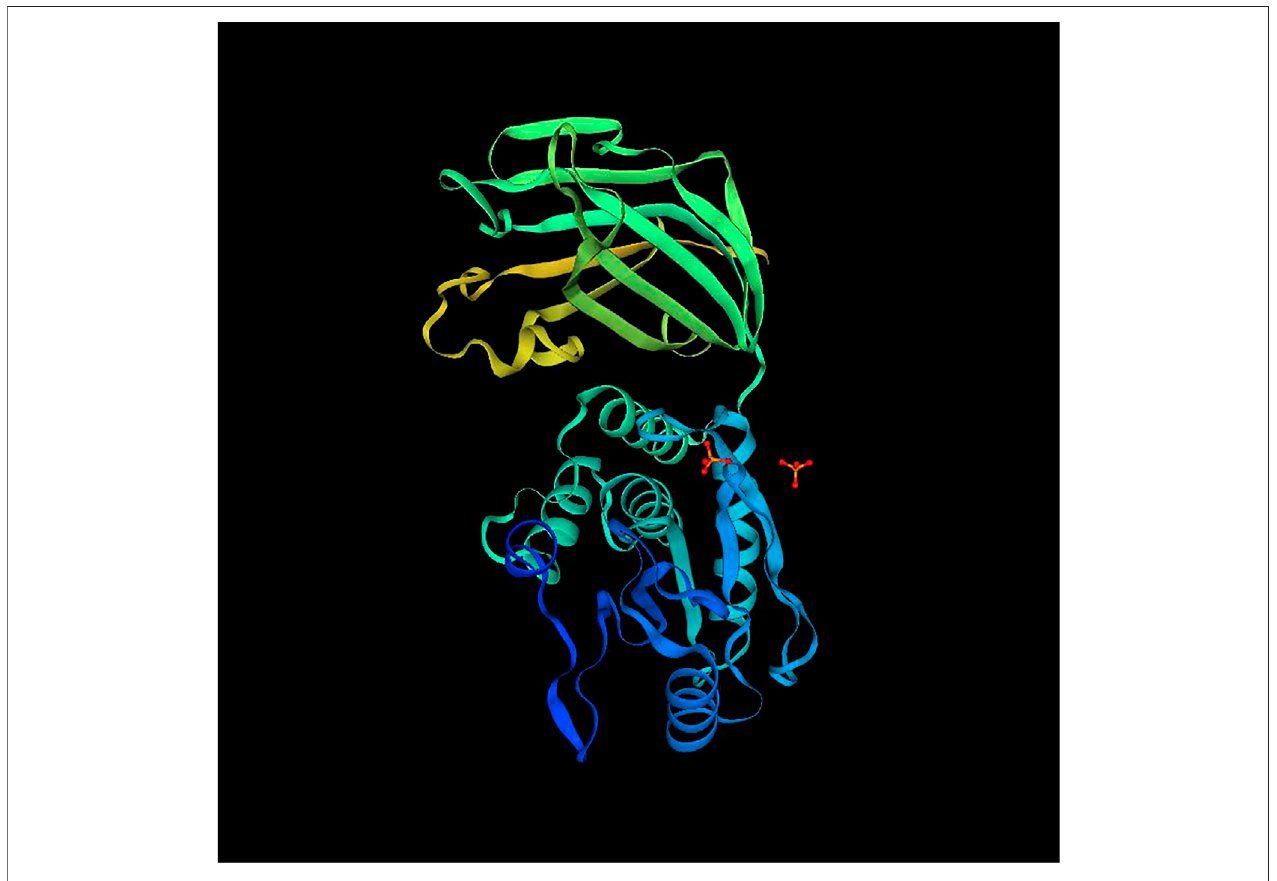
FIGURE 3 | The 3D structure of PTEN